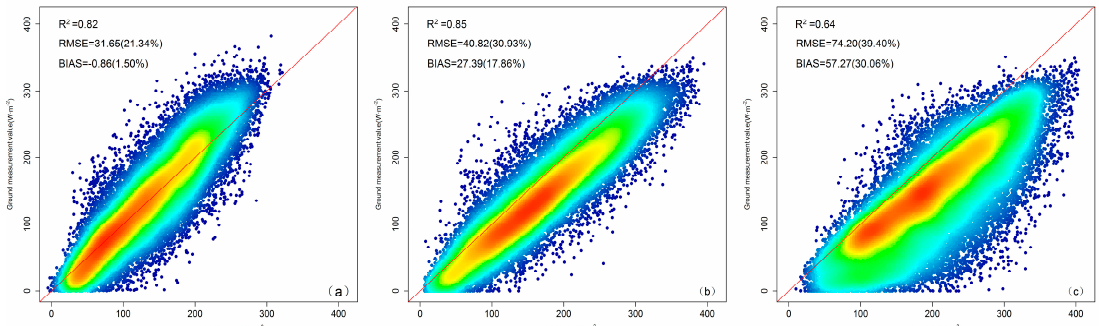
Figure 14. Scatter plots comparing the results from ( a ) the GBRT-based DSR model, as well as the DSR products ( b ) the Global Energy and Water Cycle Experiment-Surface Radiation Budget (GEWEX-SRB) and ( c ) Modern-Era Retrospective analysis for Research and Applications ( MERRA) against ground measurements in 2003. The number in the parentheses is the percent bias or RMSE value.